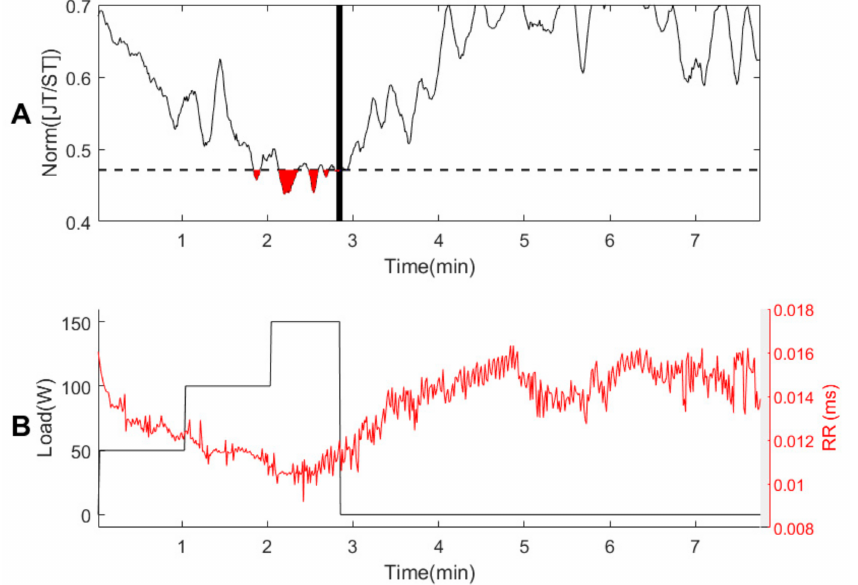
Figure 9. The dynamics of the JT/ST relationship during the load and the recovery processes for person #8. The x -axis in parts ( A , B ) represents the time (measured in minutes) from the beginning of the cycle ergometry exercise. The left y-axis in part ( B ) represents the power of the load in Watts. The right y-axis in part ( B ) represents the variation of the RR interval in ms. The algebraic JT/ST relationship is represented by the thin dashed black line in part A. The thick black solid vertical line in part A marks the end of the load.